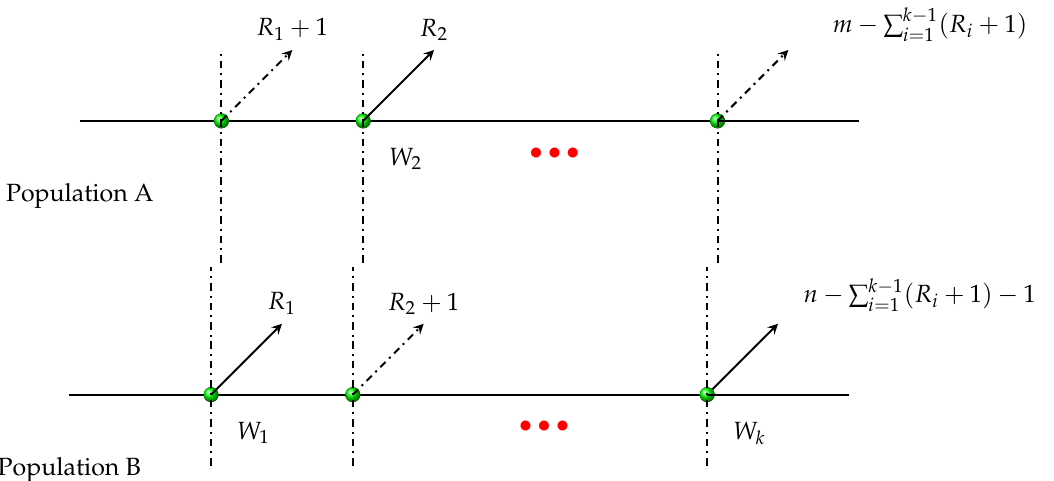
Figure 1. Schematic representation of the k -th failure occurring in population A.